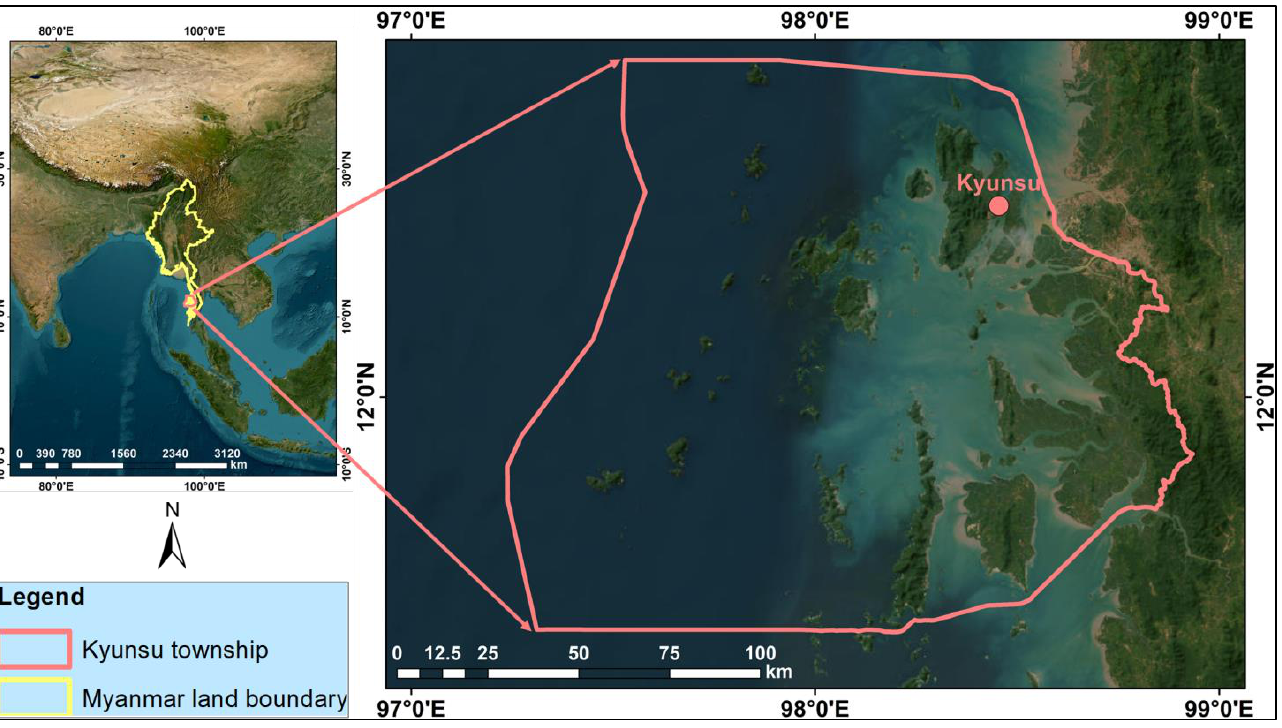
Figure 1. Map of Kyunsu township in Southern Myanmar ([23]; (ESRI, Maxar, GeoEye, Earthstar Geographic, CNES/Airbus DS, USDA, USGS, AeroGRID, IGN, and GIS User Community (2022). The boundary of the study area was digitized based on an Open Street Map using ArcGIS Desktop 10.4.1 developed by Environmental Systems Research Institute (ESRI) in 2016 [24].